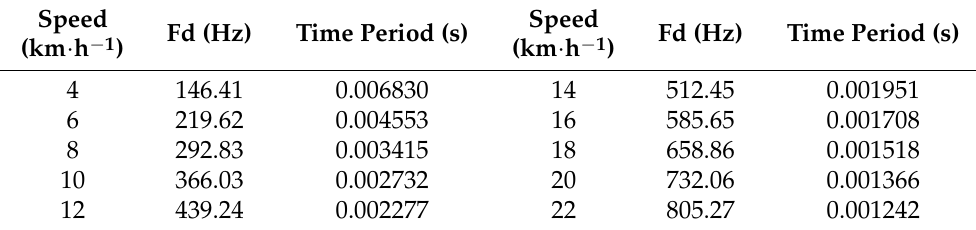
Table 1. The frequency and period of the output signal of the speed radar at the target speed.